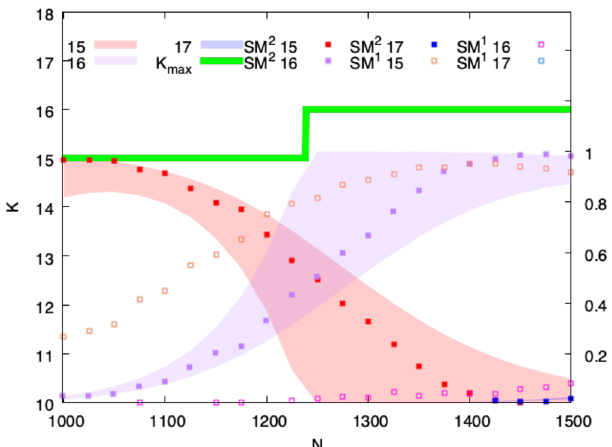
Figure 6. Across a single step in K max , this figure compares the fraction of graphs predicted to have each value of K max from equation (4) with the experimental probability obtained using SM 1 and SM 2 . The left y -axis shows the clique number, i.e. the largest clique size K max as a function of N . The right y -axis indicates the fraction of K max 1 , K max , K max 1 , obtained from the experiments with SM 1 and SM 2 . Each fraction has been computed − + 0.5 ) . The regions coloured in red, purple, and blue on a population of 500 random Erdös-Rényi graphs G ( N , p = identify the theoretical probability obtained by equation (4). The filled square points describe the fraction of K max 1 , K max , K max 1 (red, purple, and blue respectively) obtained from experiments with SM 2 , the empty − + squares the same for SM 1